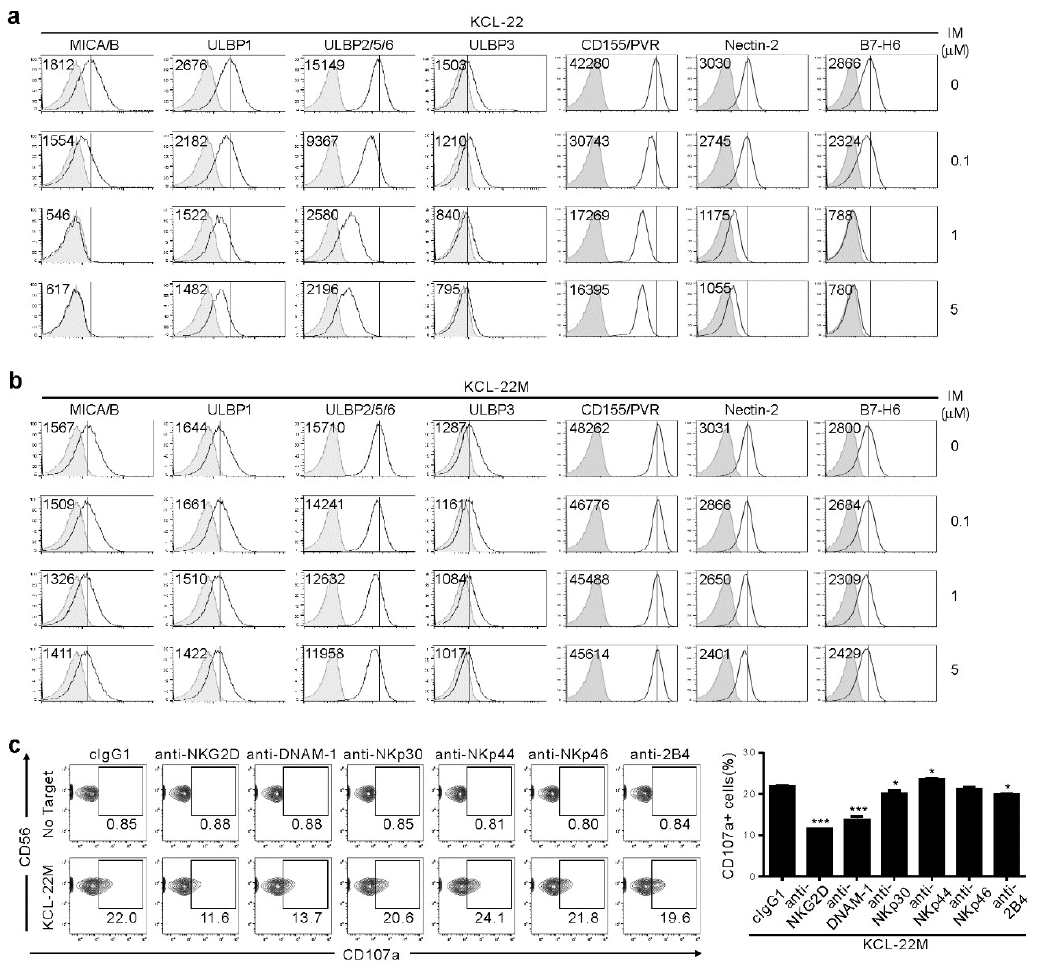
Figure 2. Association of NKG2DL and DNAM-1L expression with the susceptibility to NK cells after IM treatment. ( a , b ) KCL-22 ( a ) or KCL-22M cells ( b ) were cultured for 48 h with the indicated doses of IM. Thereafter, cells were analyzed for the surface expression of MICA / B, ULBP1, ULBP2 / 5 / 6, and ULBP3 for NKG2D receptor, PVR and Nectin-2 for DNAM-1 receptor, or B7-H6 for NKp30 receptor by flow cytometry. The representative mean fluorescence intensity (MFI) of each ligand (upper left) in the histogram is presented as the result of three independent experiments. The solid lines indicate isotype control staining. ( c ) KCL-22M cells were pretreated with IM (5 µ M) for 48 h, washed, and then, mixed with expanded primary NK cells preincubated with mAb to the indicated receptors (20 µ g / mL) for 2 h. Degranulation of NK cells was measured by percent expression of CD107a on CD3 − CD56 + NK cells. Representative flow cytometry profiles ( left ) and a graph of statistical bar charts ( right ), demonstrating the percentage of CD107a + NK cells. The mean values ± s.d. of three independent experiments are shown. * p < 0.05; *** p < 0.001 by Student’s t -test.